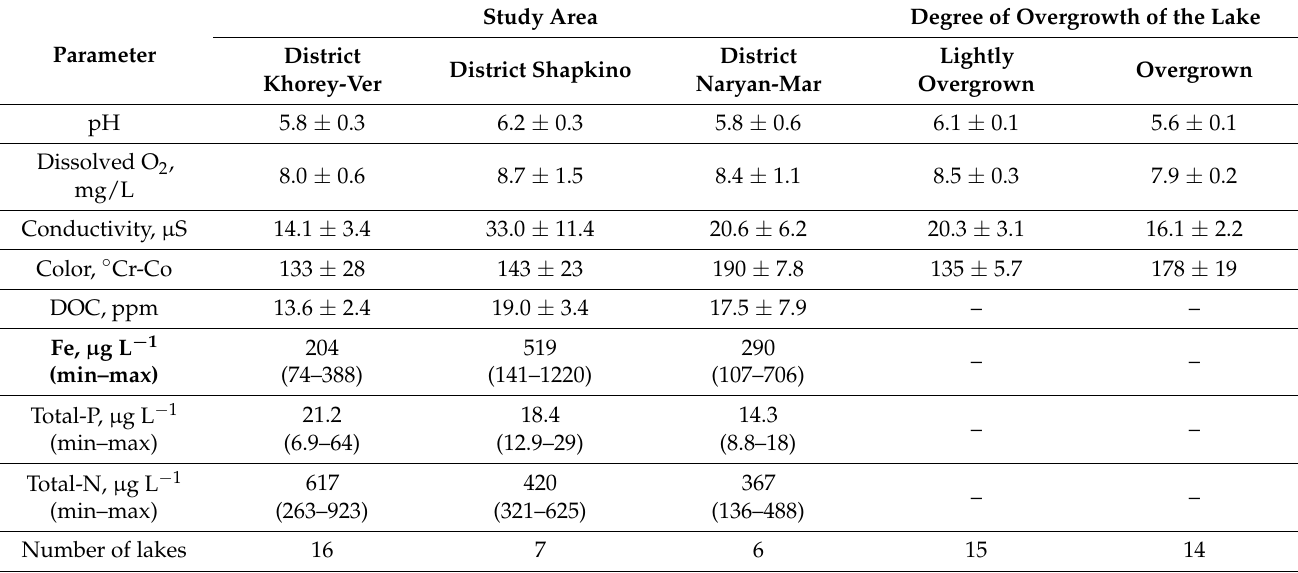
Table 1. Characteristics of the studied lakes by hydrochemical indicators (average